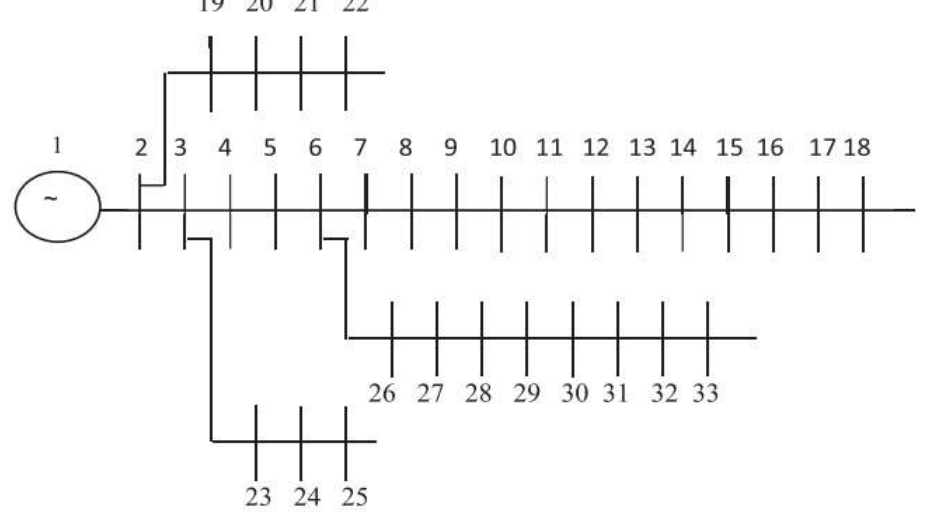
Figure 2. IEEE 33-bus distribution network.